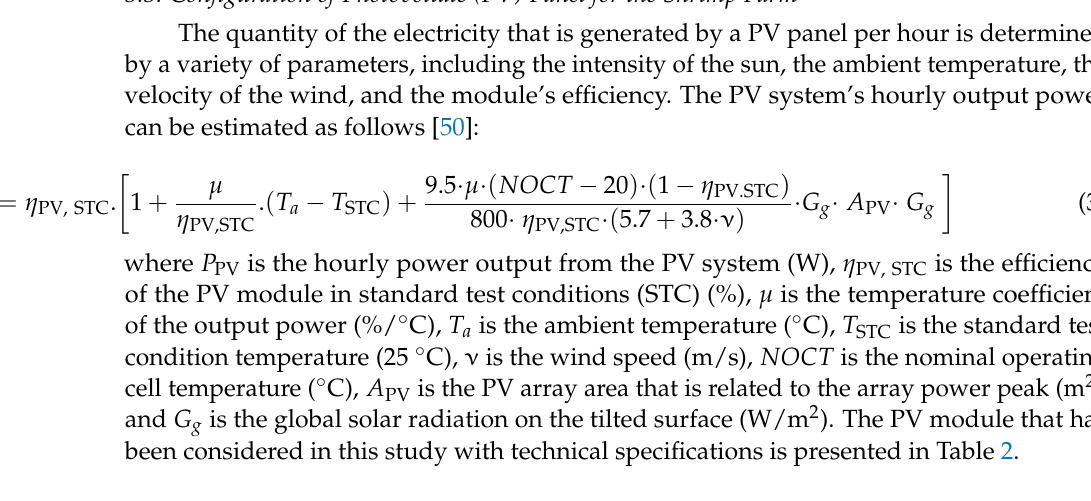
Figure 5. Monthly electricity consumption profile of the single shrimp farm.